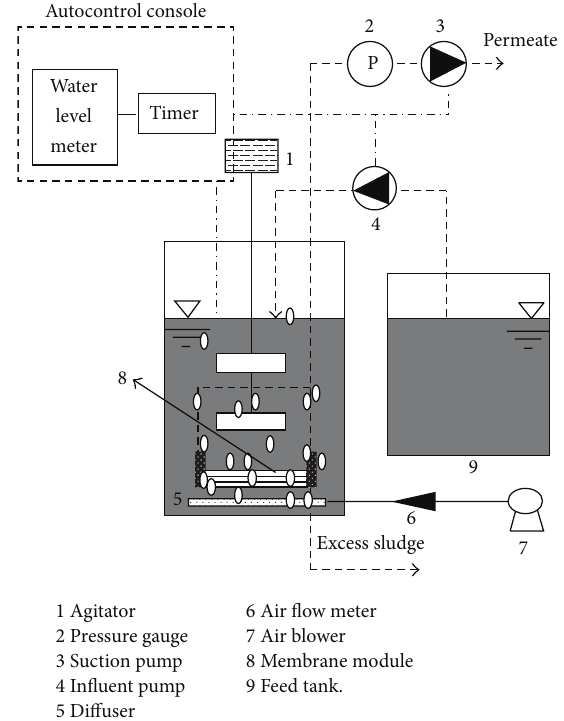
Figure 1: Schematic diagram of the bench-scale